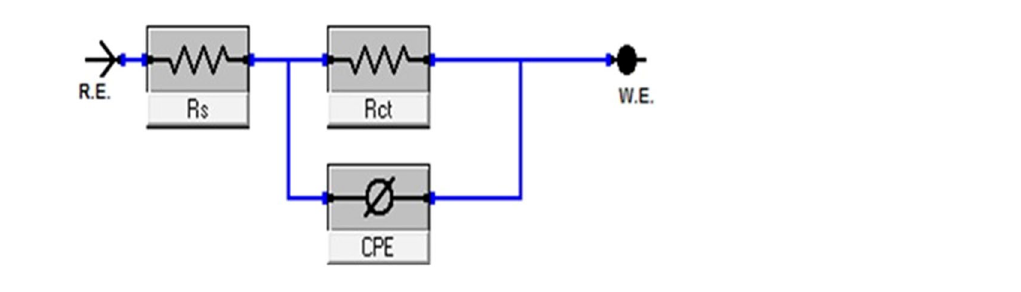
Figure 9. Equivalent circuit model used to fit the impedance